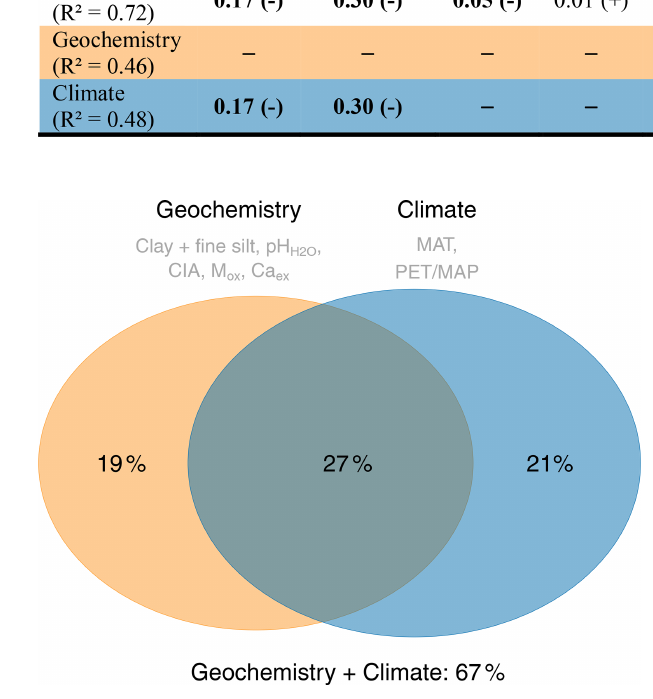
Figure 3. Venn diagram illustrating the independent and shared variation explained by the geochemistry-only and the climate-only linear mixed-effects